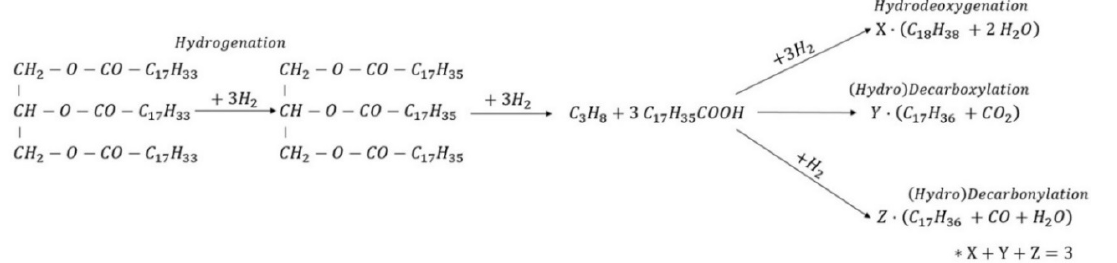
Figure 4. Reaction pathways in the hydrotreatment of triacylglycerol